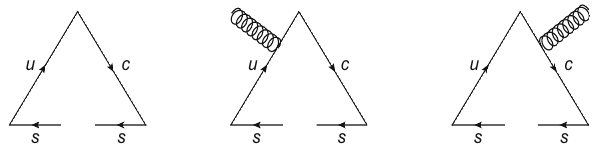
Fig. 2 Non-perturbative diagrams for the off-shell D meson